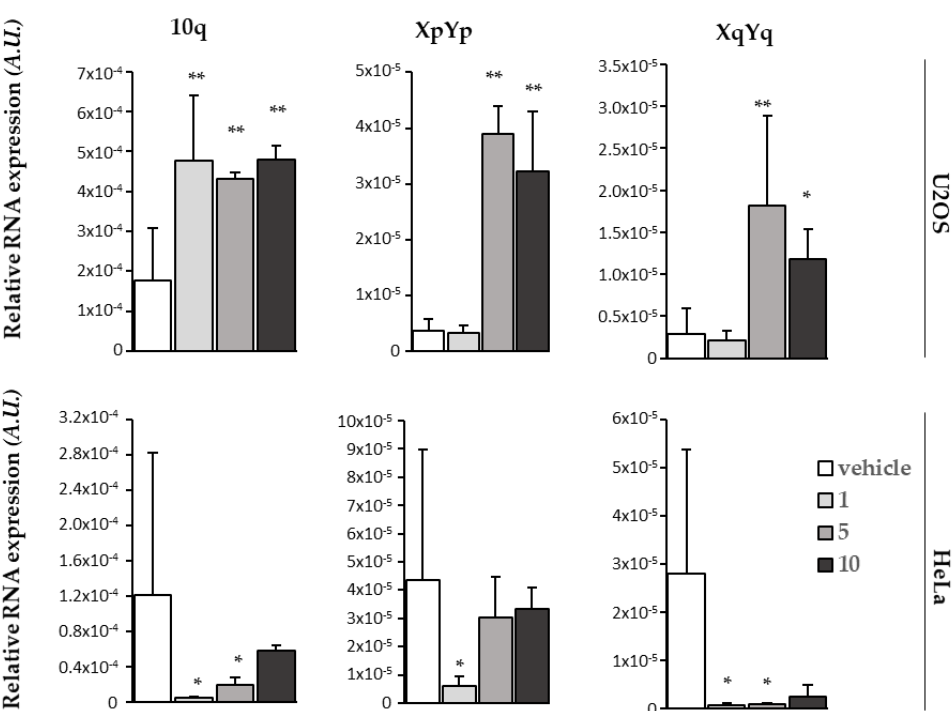
Figure 8. Effect of BPBA on TERRA expression. RT qPCR showing relative expression of specific TERRA RNA at different subtelomeric loci of HeLa and U2OS cells treated with the vehicle or indicated doses (1, 5, or 10 µM) of BPBA for 72 h. Mean of three independent experiments is shown. Error bars are SD; * = p < 0.5; ** = p < 0.1.